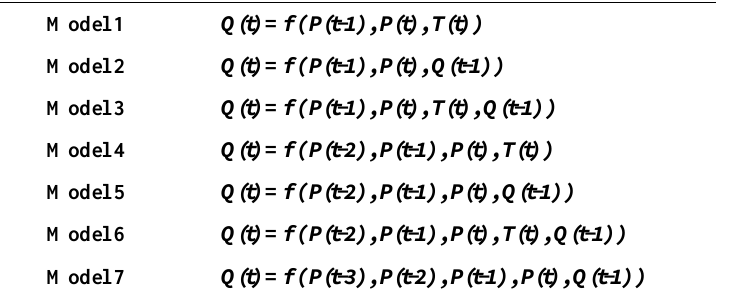
Table 1. The patterns used as inputs to the ANN model